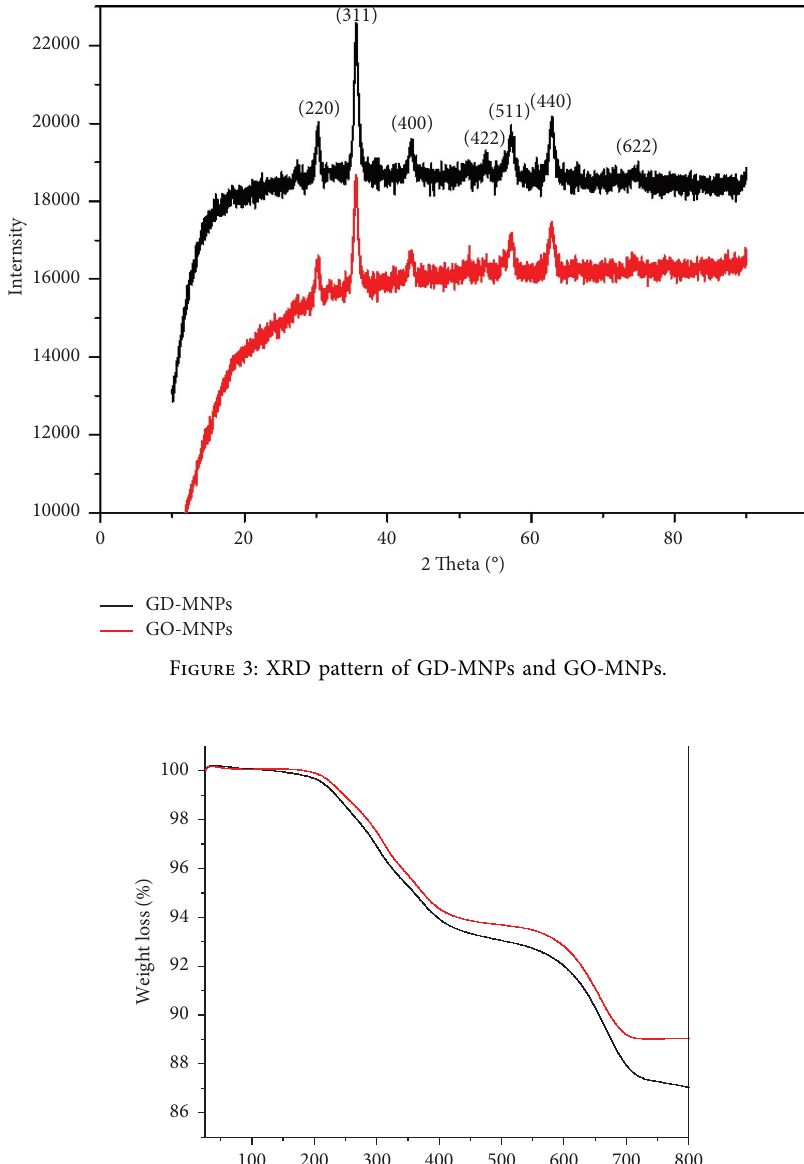
Figure 4: TGA analysis of GO-MNPs and